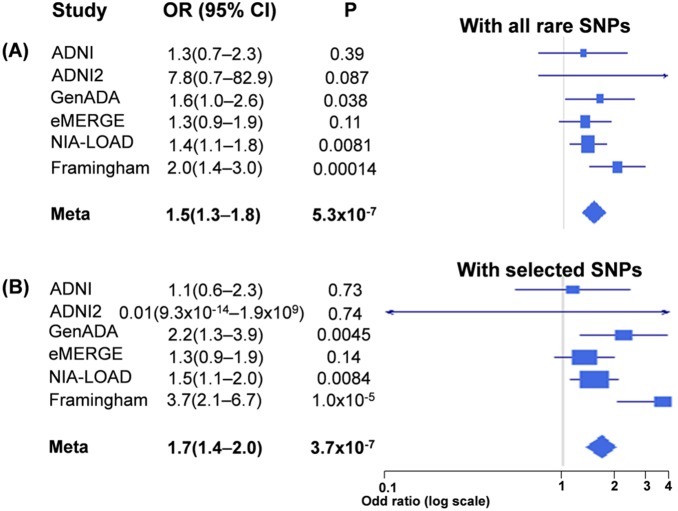
Forest plots showing the association of ZNF628 with AD.Results are (A) with all rare SNPs (the first meta-analysis) and (B) with only selected risk SNPs (the second meta-analysis). The weight of each study was calculated by 4/(1/NAD+1/NC), where NAD and NC are numbers of AD and controls, respectively [35].